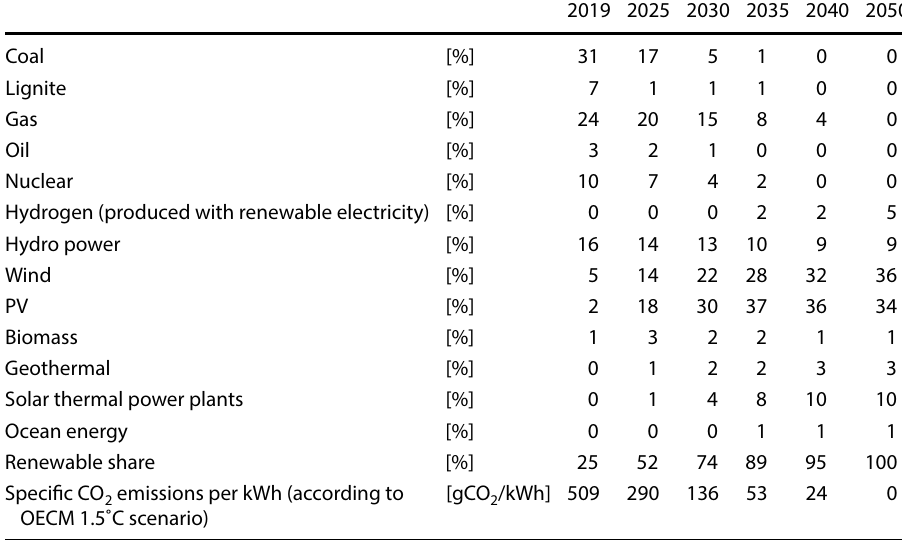
Table 18 Electricity supply under the OECM 1.5 °C